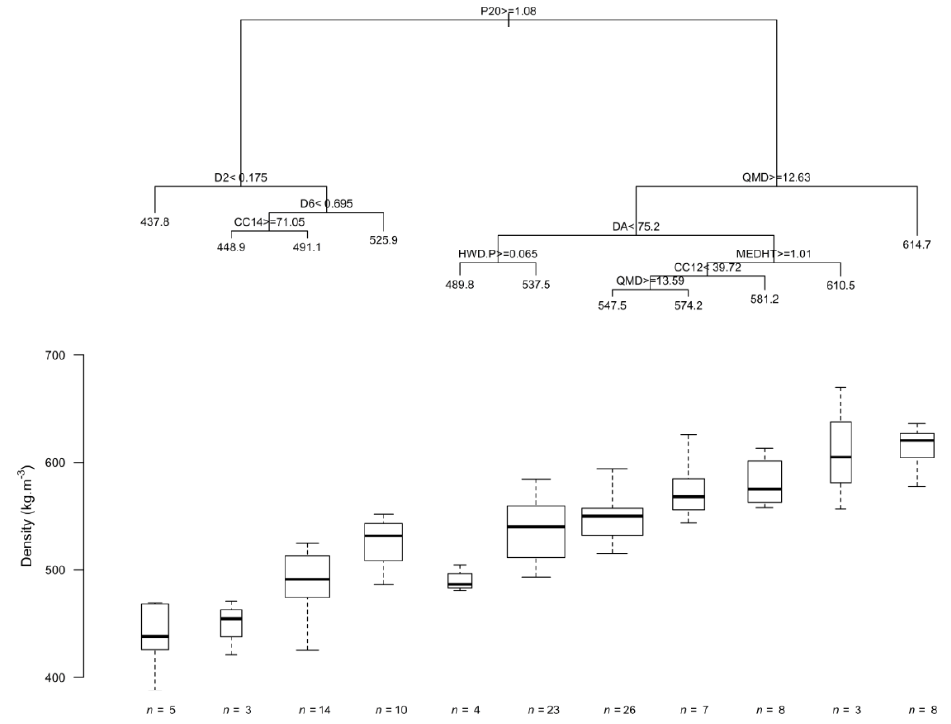
Figure 3. Regression tree analysis to predict the wood density of an average black spruce tree in a given stand using LiDAR-derived predictor variables for a sample tree population representing black spruce in the boreal forest of northeastern Ontario, Canada. Note: for each decision node, if true, move to the left. Variables used in regression trees are: HWD.P = hardwood proportion in the stand; MEDHT = median height in m; QMD = quadratic mean diameter in cm; P20 = second decile LiDAR height in m; DA = first returns/all returns (%); CC12 = crown closure > 12 m (%); D2 = cumulative % of the number of returns found in bin 2 of 10 (%); D6 = cumulative % of the number of returns found in bin 6 of 10